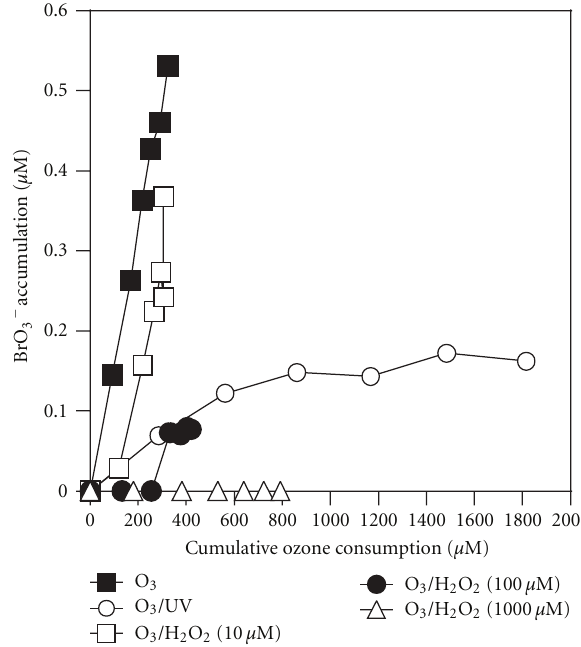
Figure 10: Relationship between cumulative ozone consumption and BrO 3 − accumulation during each treatment with 4-CBA addi- tion at neutral pH. Each treatment continued 30